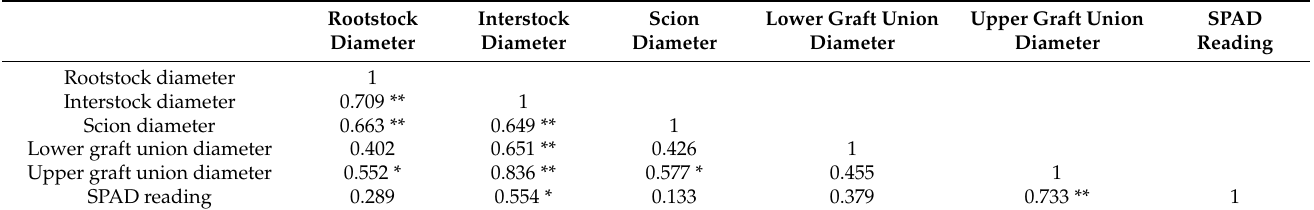
Table 4. Correlation analysis of SPAD reading and vegetative growth.